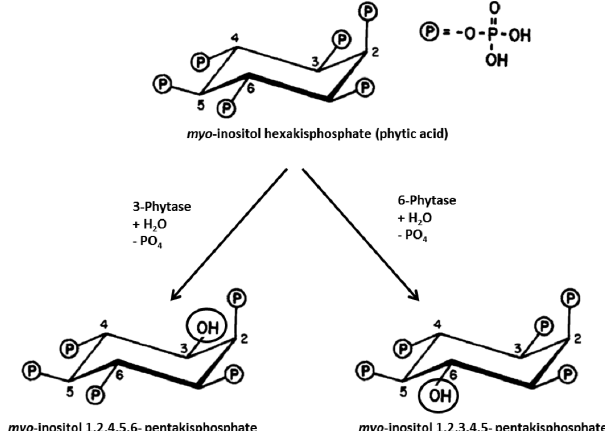
Figure 1. Phytic acid (IP 6 ) degradation to IP 5 by 3-phytases and 6-phytases (modified from Dvoˇráková, 1998). 3-Phytases first hy- drolyze the ester bond at the 3-position of IP 6 ( myo − Inositol hex- akisphosphate), which leads to the formation of IP 5 ( myo -inositol 1,2,4,5,6-pentakisphosphate) and free inorganic phosphate. In con- trast, 6-phytases first hydrolyze the 6-position, which leads to the formation of IP 5 ( myo -inositol 1,2,3,4,5-pentakisphosphate) and free inorganic phosphate. The numbering of the carbon atoms cor- responds to the numbering for the D